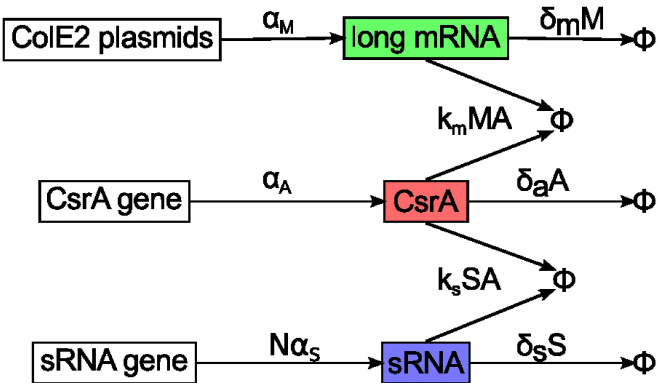
Fig 2. Simplified interaction schemefor post-transcriptional regulation of long mRNA. M,A,S: moleculenumbers of free long mRNA, free CsrA dimers and the free effective sRNA; α : productionrates; δ : degradationrates; k : effective rate of coupleddegradation. The interactionnetwork(see S1 Fig) of the regulatorysystem depictedin Fig 1 was reducedto a three componentsystem. In both figures, the corresponding componentshave the same colors. In particular, we combinedthe complex dynamics(binding, dissociation, degradation) into an effective coupleddegradation. The dynamicsof sRNA complexes with N bindingsites for CsrA and productionrate α S were simplifiedto the dynamics of an effective sRNA with one CsrA bindingsite but N-times higherproductionrate (S1 Text).